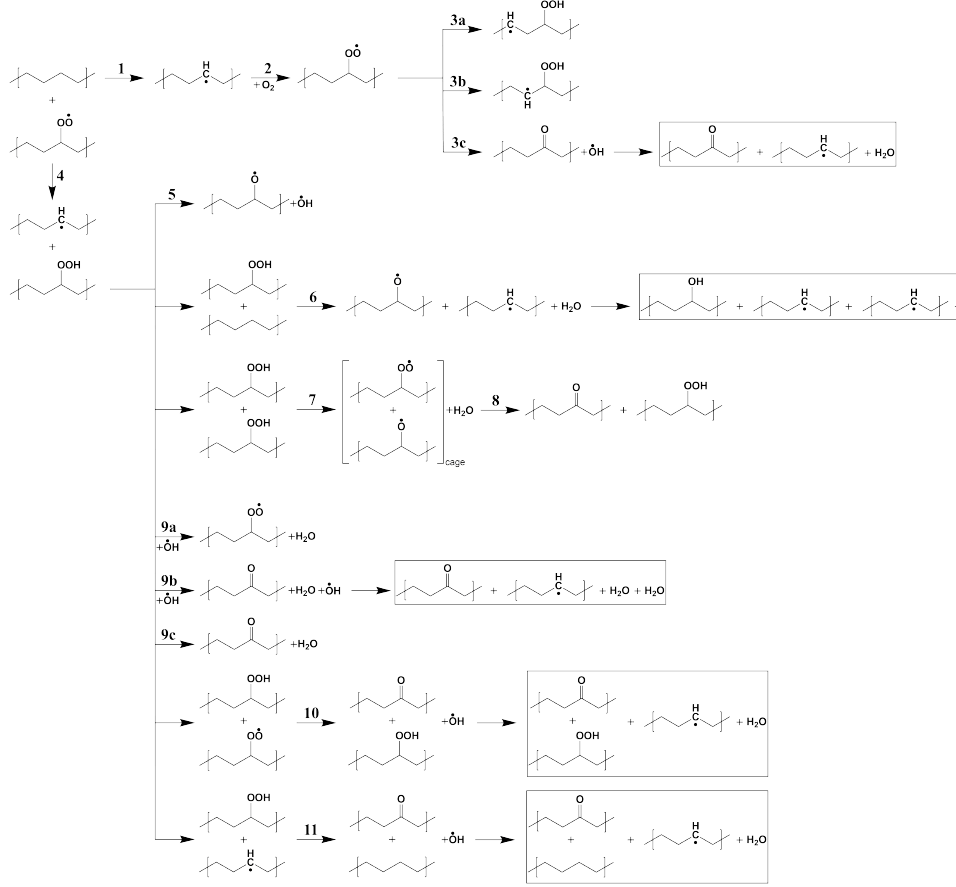
Figure 2. A summary of reaction paths leading to the (radio)-oxidation of polyethylene in the form of ketones. Starting from the production of alkyl radicals (typically by irradiation, reaction 1), the capture of O 2 molecules follows (reaction 2). The chain reaction can proceed through the formation (then decomposition) of hydroperoxides either by unimolecular reactions 3a–c, or by bimolecular reaction 4 and then unimomolecular or bimolecular reactions 5–11. The main stable final products are ketones and water molecules, while hydroperoxides, hydroxyl radicals and peroxy radicals will take part in further reactions, together with alkyl and alkoxy